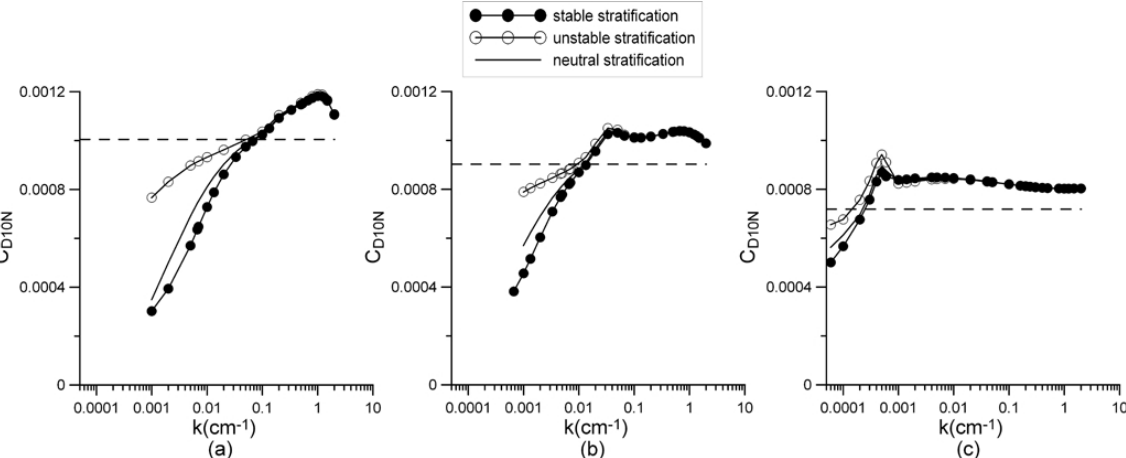
Fig. 8. Dependencies of the drag coefficient of the water surface on the wave length for u ∗ = 5cms − 1 (a) , u ∗ = 10cms − 1 (b) , u ∗ = 50cms − 1 (c) .